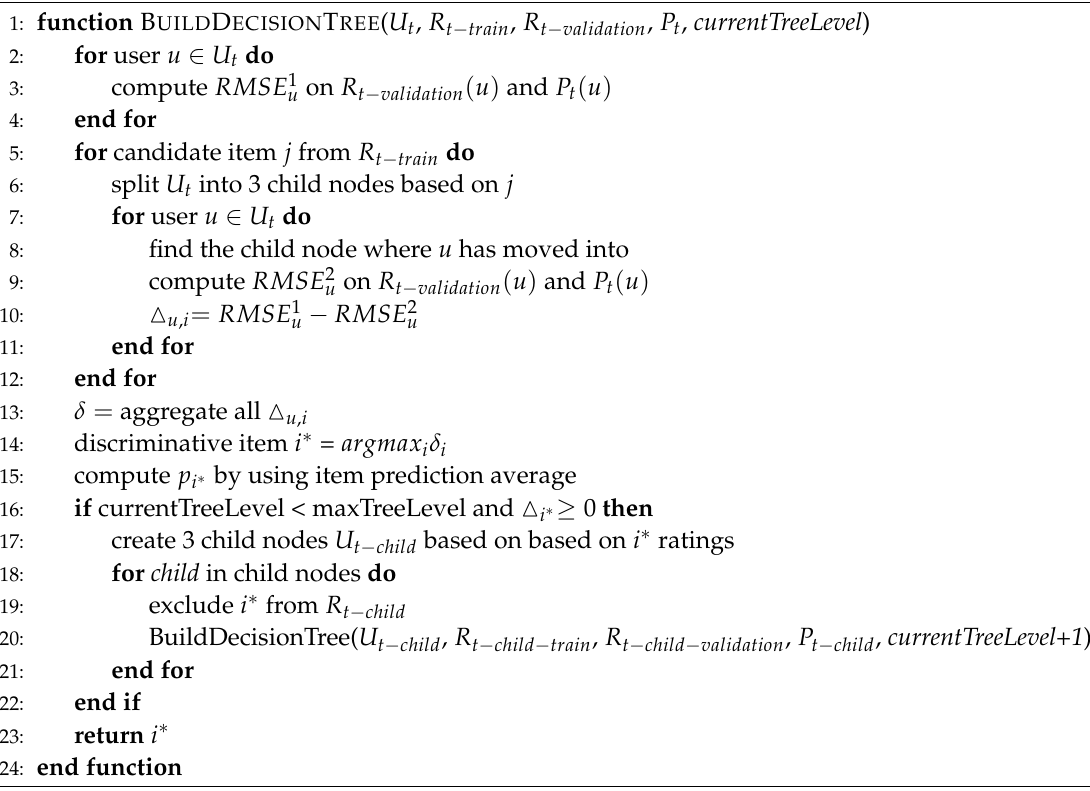
Algorithm 2 Supervised decision tree